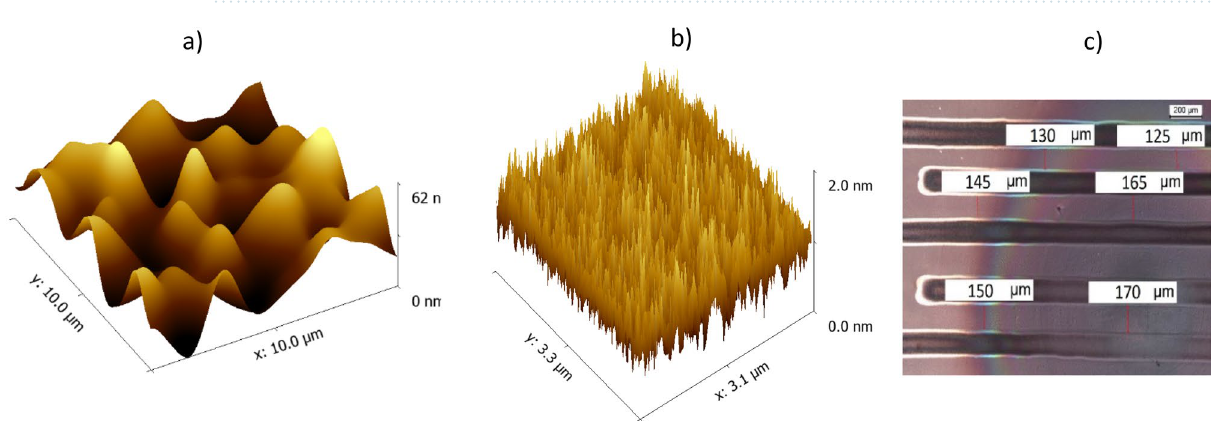
Figure 2. AFM image of the surface topology for a printed Ag conductive pad ( a ) and PVP dielectric layer ( b ). Optical microscope view of the semiconductor layers printed using optimized ink (the widths of the paths are indicated in the white boxes) ( c